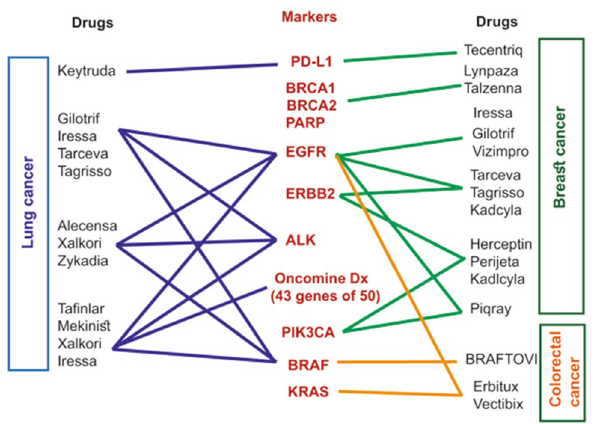
Figure 3. COVID-19 network engages companion diagnostic markers of anti-cancer drugs. Approved by FDA markers for companion diagnostic were retrieved from the COVID-19 network. Retrieved markers are shown in connection to the corresponding anti-cancer drugs used for treatment of lung, breast and colorectal